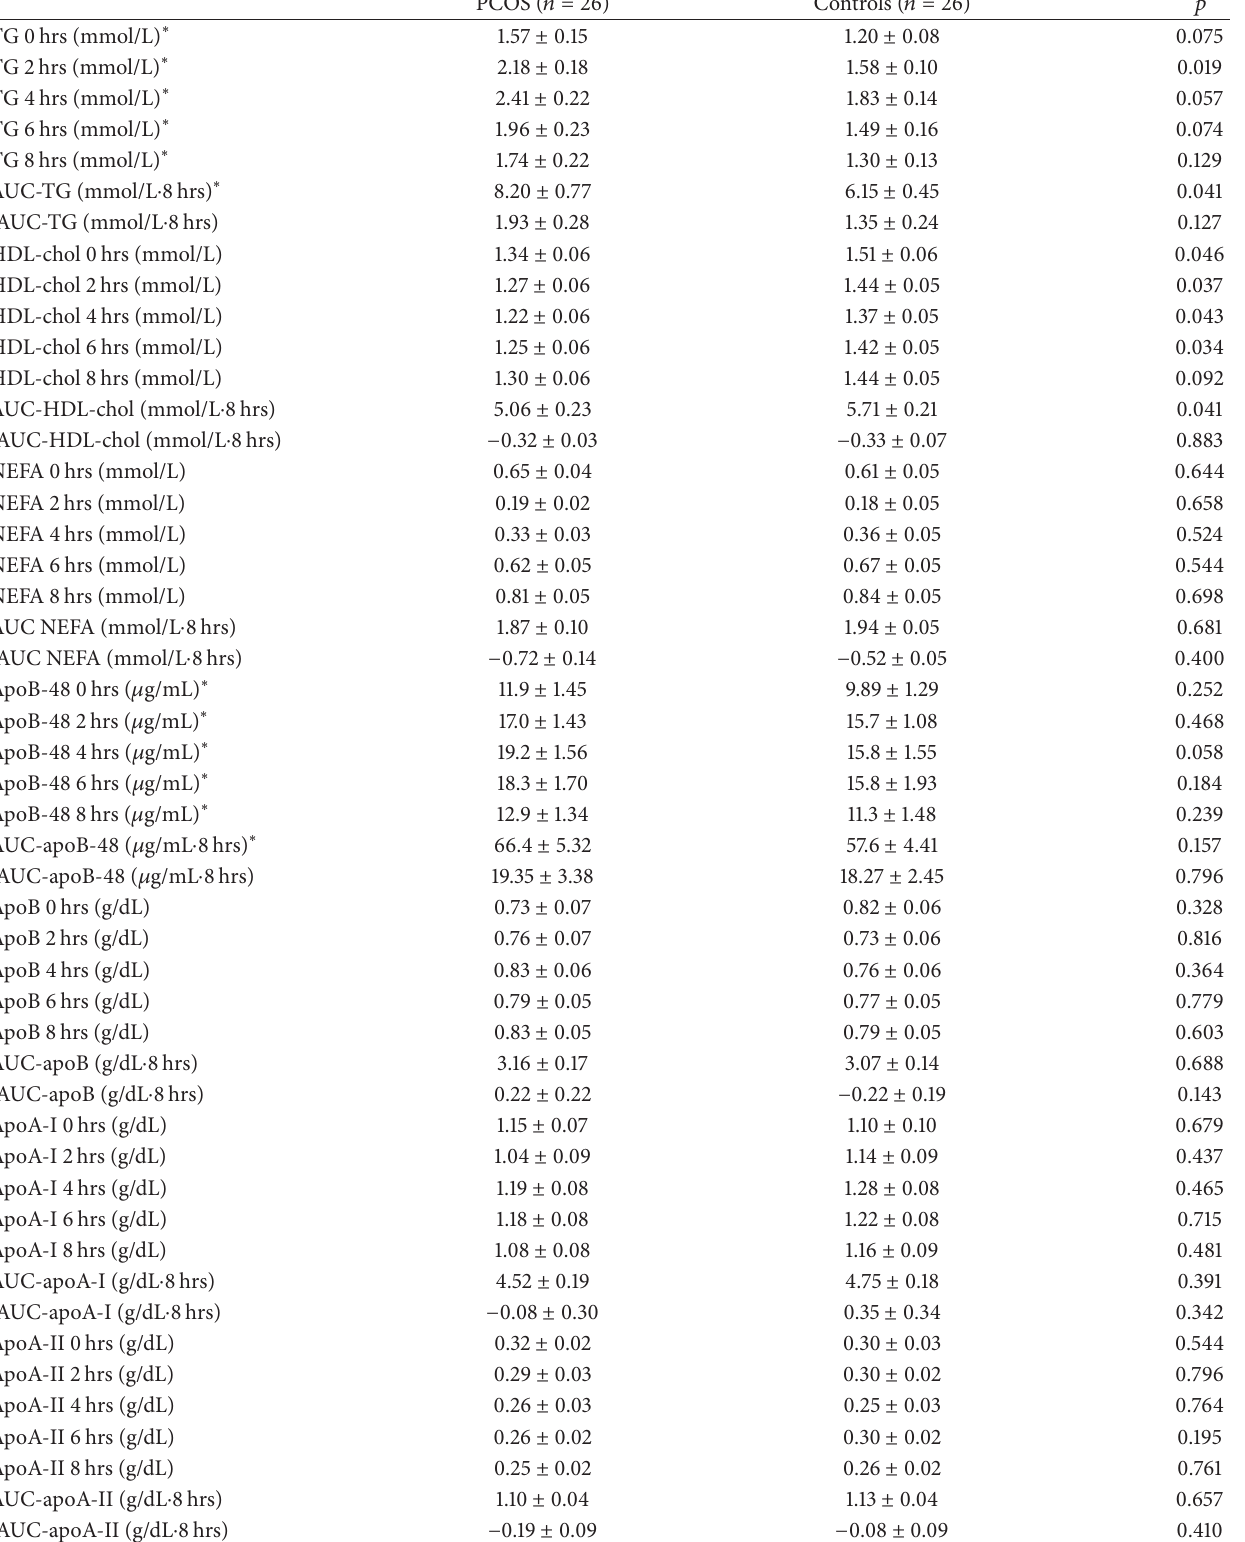
Table 2: Postprandial triglycerides, HDL-chol, NEFA, and